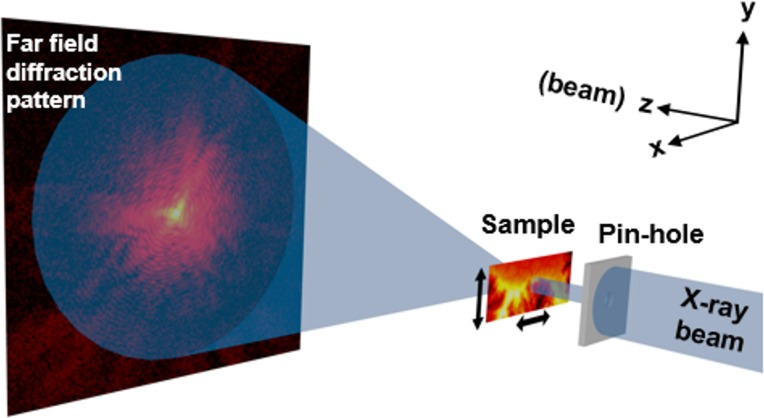
Sketch of the experimental setup for transmission X-ray ptychography.Coherent diffraction patterns are recorded by a 2D detector for a set of partially overlapping scanning positions, allowing numerical reconstruction of the projected complex-valued image of the sample.